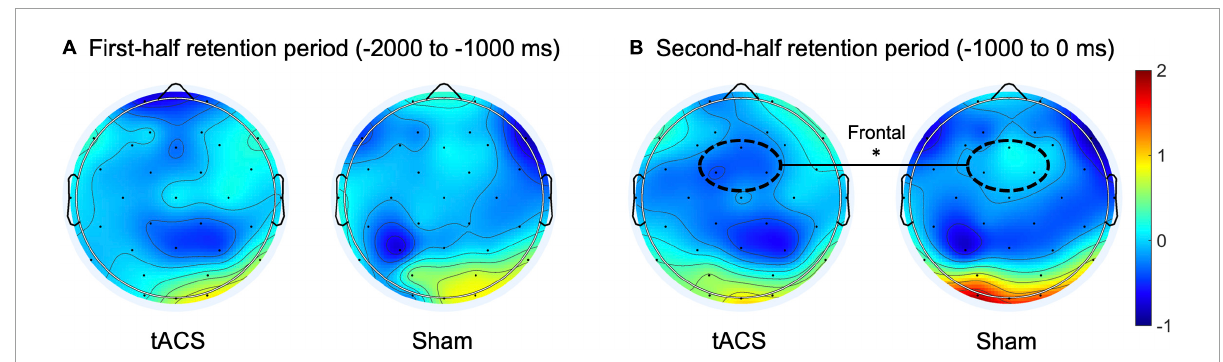
FIGURE4 Transcranial alternating current stimulation (tACS)-mediated topographical changes in alpha power. The grand-averaged Z -scores of differences in alpha power (normalized Z -scores at individual alpha frequencies) between pre- and post-treatment (post-treatment minus pre-treatment) during (A) the first half and (B) the second half of the retention periods in both the tACS-treated and sham groups. The dotted curves indicate the frontal (Fz, FC1, and FC2) region of interest. The asterisk represents statistical significance between tACS-treated and sham groups (* p < 0.01). The view of the topography is from the vertex, with the nose at the top of the